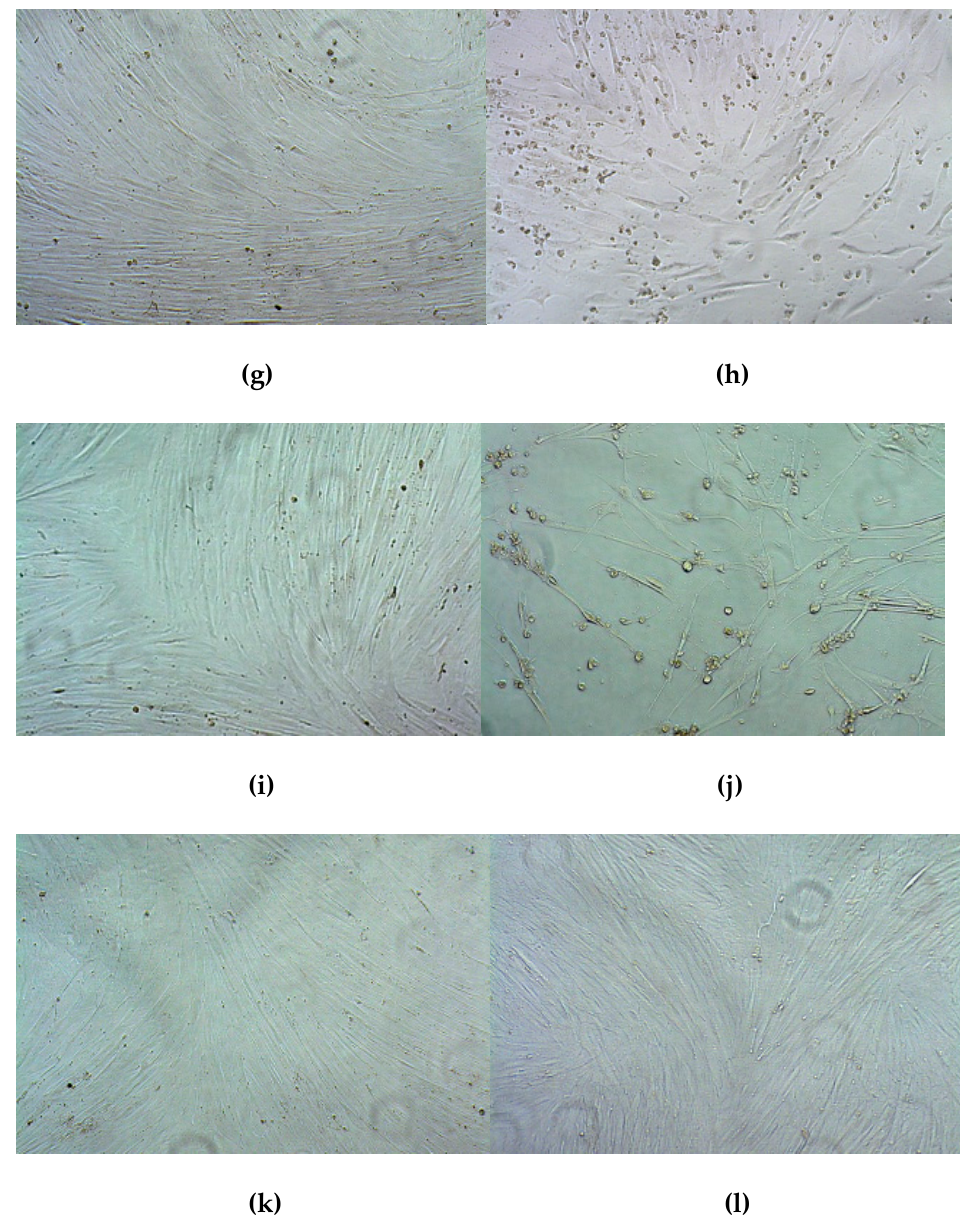
Figure 10. Typical microphotographs in bright field done 96 h after GCV treatment. The UL cells were transfected with RGD1-R6/pCMV-lacZ polyplexes at N/P ratios of ( a ) 8/1, ( c ) 12/1; with RGD1-R6/pPTK1 complexes at ( b ) 8/1, ( d ) 12/1 charge ratio; with RGD1/pCMV-lacZ polyplexes at N/P ratios of ( e ) 8/1, ( g ) 12/1; with RGD1/pPTK1 complexes at ( f ) 8/1, ( h ) 12/1 charge ratio; with PEI/DNA complexes using ( i ) pCMV-lacZ and ( j )pPTK1 plasmids. Control wells contained ( k ) GCV treated cells and ( l ) untreated intact cells.